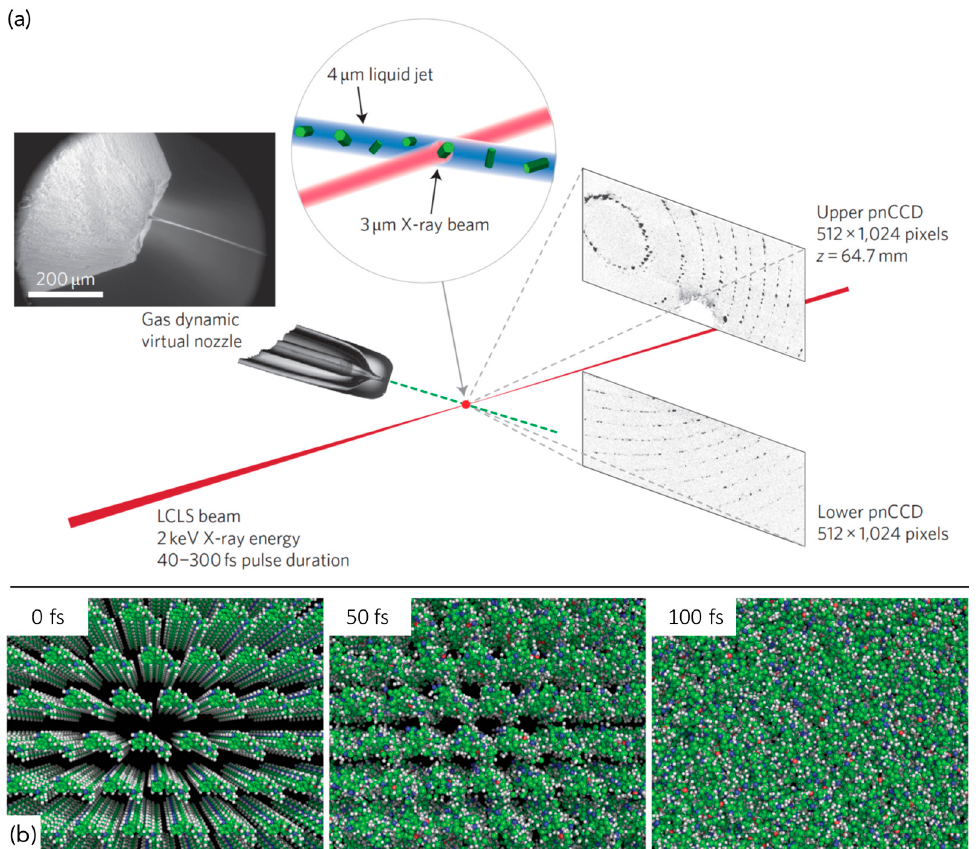
Figure 6. Serial fs-nanocrystallography (SFX) approach. ( a ) A suspension of µm-crystals flows in a liquid jet across the X-ray beam, and diffraction is recorded using a pair of 512 × 1024-pixel pnCCD detectors. The lower half detector is placed further from the beam center than the upper half detector to increase the accessible range of scattering angles. Thousands of individual diffraction patterns are recorded from single µm-crystals with pulse lengths up to 300 fs to a resolution of 0.76 nm. ( b ) Onset of disorder in a crystalline lattice during an ultra-intense 100-fs X-ray pulse. Sample: lysergic acid diethylamide. Atomic displacements were calculated using Cretin [93]. For this small molecule, crystalline order is largely destroyed by 100 fs. Adapted from Reference [92] with permission from Springer Nature.